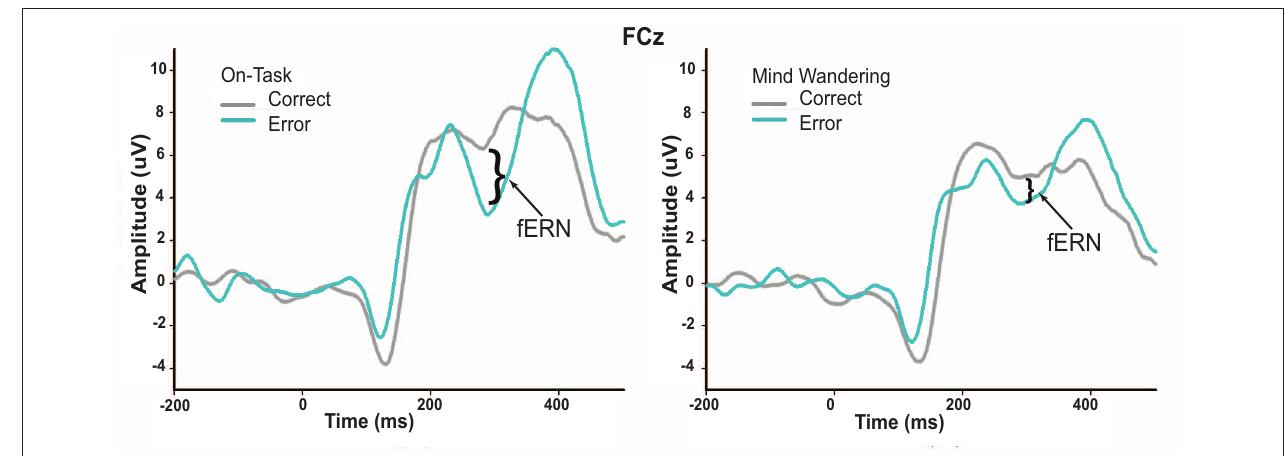
FIGURE 5 | Conditional waveforms of on-task and mind wandering attentional states in response to correct and error feedback. The difference between correct and error feedback appears to be greater during on-task states relative to mind wandering states.